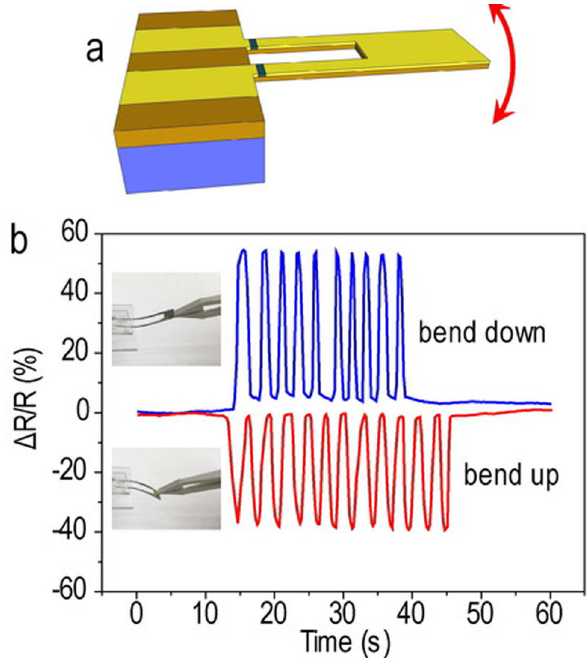
Fig. 1 GST cantilever strain sensor. a Schematic illustration of the GST-based strain sensor with GST strip at the root of the cantilever. b Time-resolved electrical response of the GST sensor with different bending